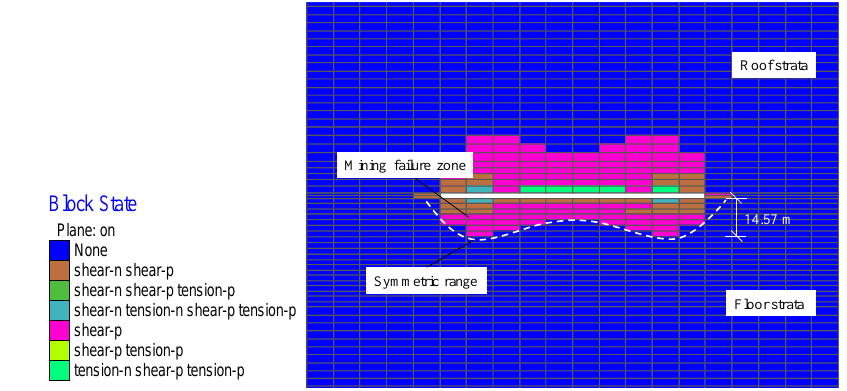
Figure 11. Distribution of the numerically obtained failure zone in the horizontal floor strata.